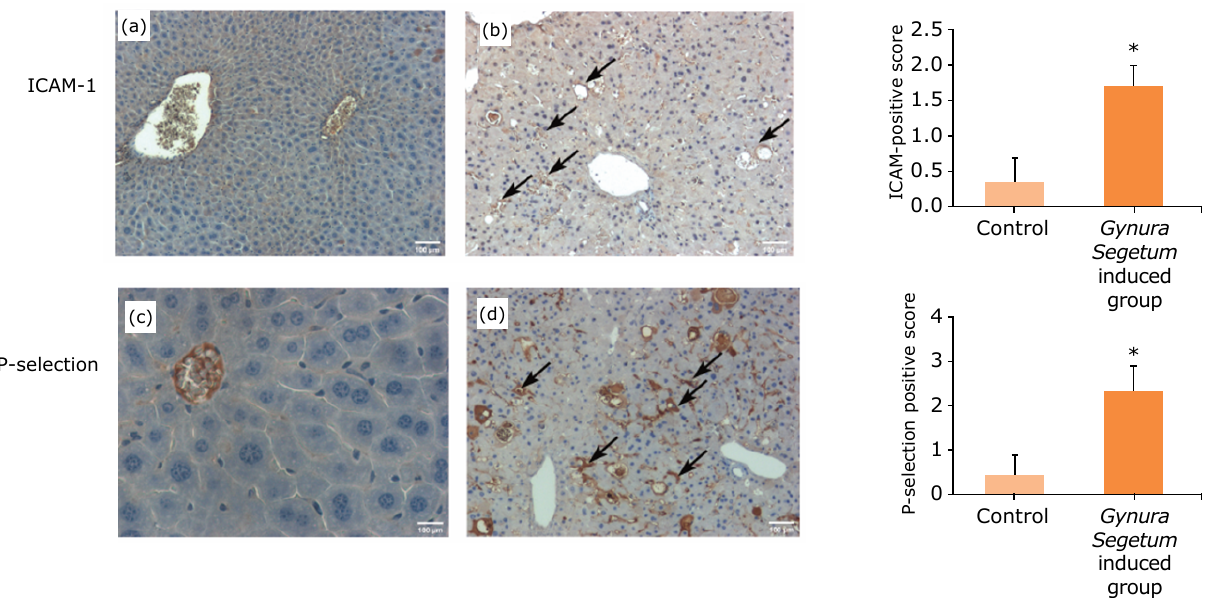
Figure 6 - Gynura segetum induced the increased expressions of inflammatory factors in mice (n = 10). Liver specimens were collected at five weeks after G. segetum administration and detected by immunohistochemistry. The arrow points to high expression. (a and c) Control; (b and d) G. segetum -induced group. Original magnification